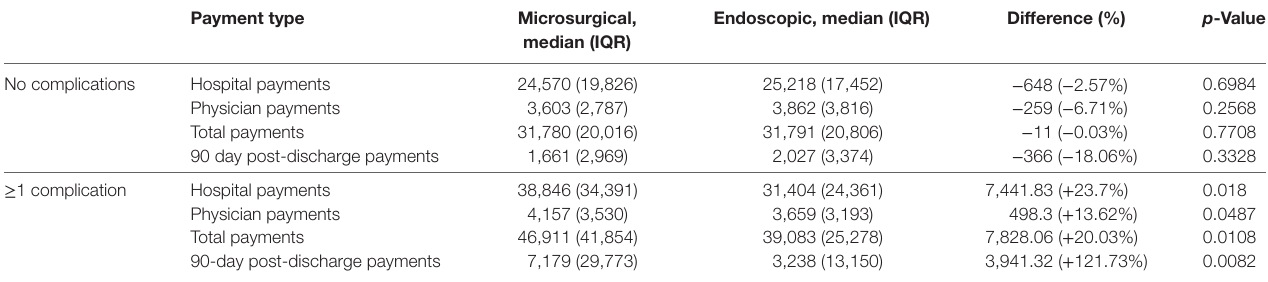
Table 6 | Costs for patients experiencing one or more complication show increased costs in the microsurgical